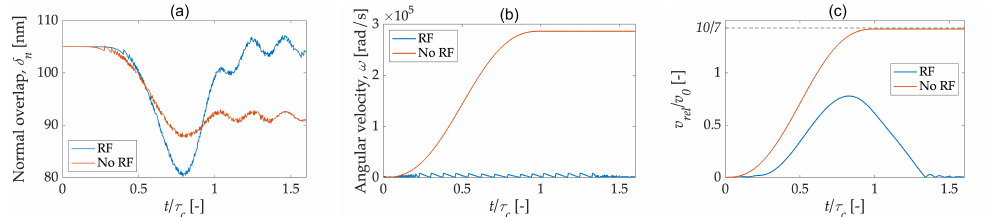
Figure 5. Evolution of ( a ) overlap, ( b ) angular velocity and ( c ) relative velocity of the API particle (with respect to the carrier) during detachment with and without rolling friction